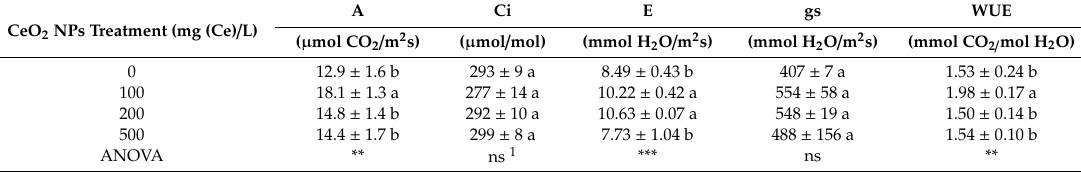
Table 2. Gas exchange parameters of green pea cultivated in Hoagland solutions with CeO 2 NPs supplementation at 0–500 mg / L of Ce. Leaf net photosynthesis (A), Sub-stomatal CO 2